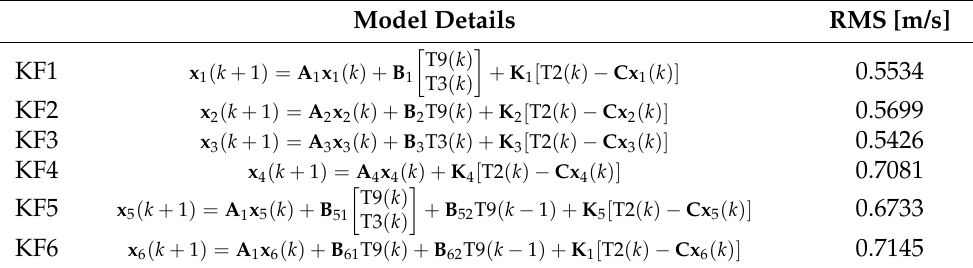
Table 2. KF model details and performance summary T9 are additional towers providing exogenous wind speed